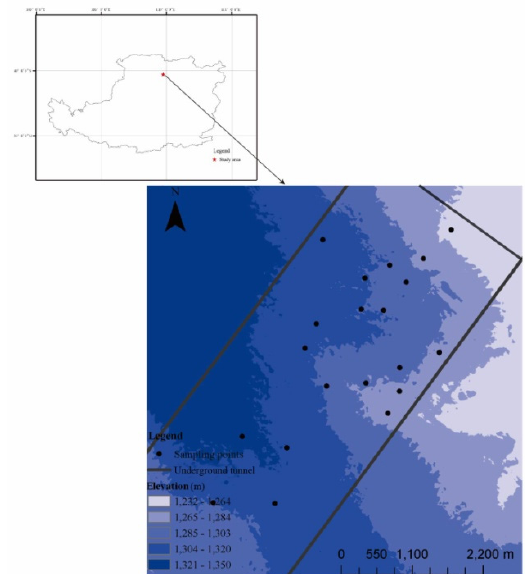
Figure 1. Study area and sampling points.